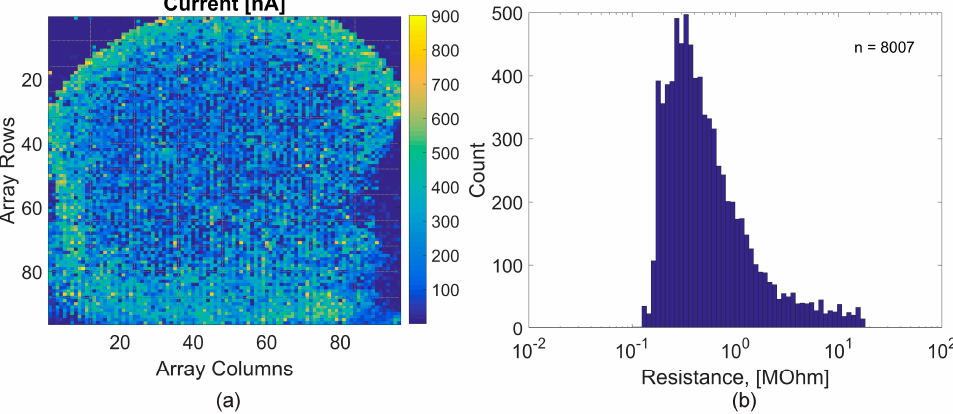
Figure 3. ( a ) Physical map of 8007 CNT-bridged electrode pairs as obtained from electrical conductance tests, ( b ) Histogram of resistance values across the whole